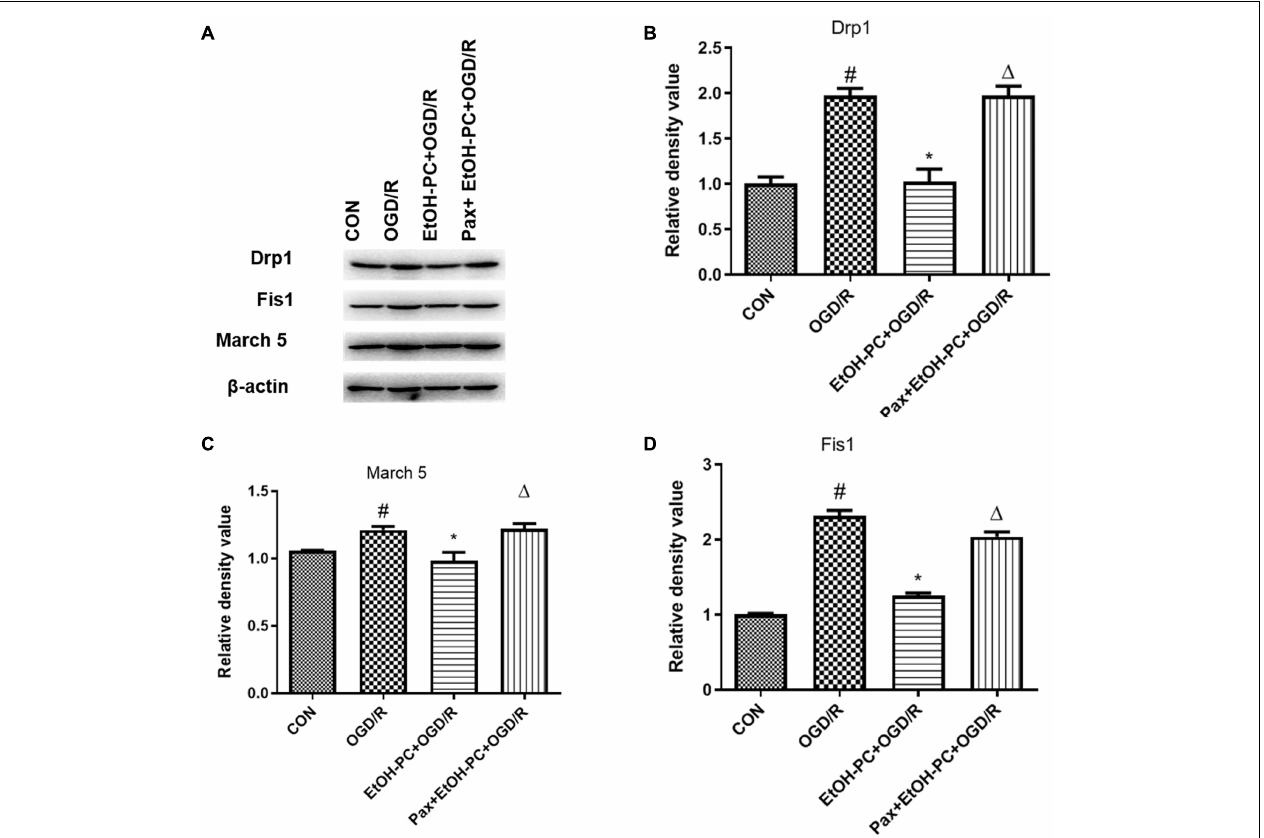
FIGURE 8 | Ethanol preconditioning downregulated intrinsic apoptosis markers during OGD/R through activating mitoBK Ca . After the neurons were preincubated with paxilline (5 µ mol/L) for 10 min and preconditioned with ethanol (10 mmol/L) followed by OGD2h/R24h. (A) Representative blots of Drp1, Fis1, and March 5, and the quantification result were shown in (B–D) . Results are expressed as mean ± S.D. ( n = 3). # P < 0.001 vs. CON; * P < 0.01 vs. OGD/R; (cid:49) P < 0.01 vs. EtOH-PC + OGD/R (B) . # P < 0.01 vs. CON; * P < 0.05 vs. OGD/R; (cid:49) P < 0.05 vs. EtOH-PC + OGD/R (C) . # P < 0.001 vs. CON; * P < 0.001 vs. OGD/R; (cid:49) P < 0.001 vs. EtOH-PC + OGD/R (D)